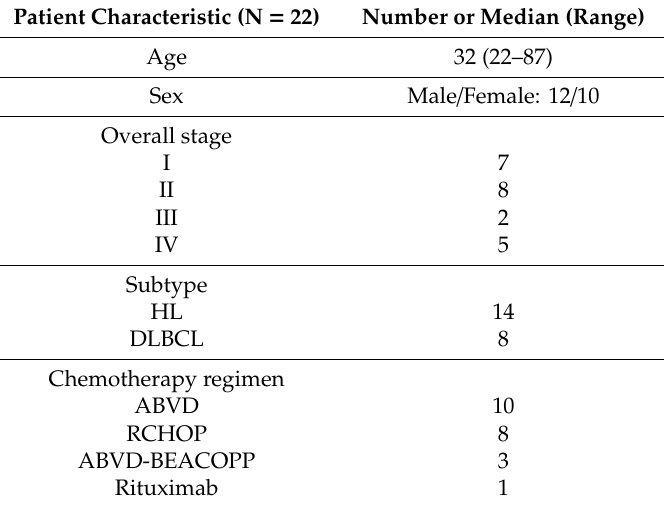
Table 2. Patients’ demographics.